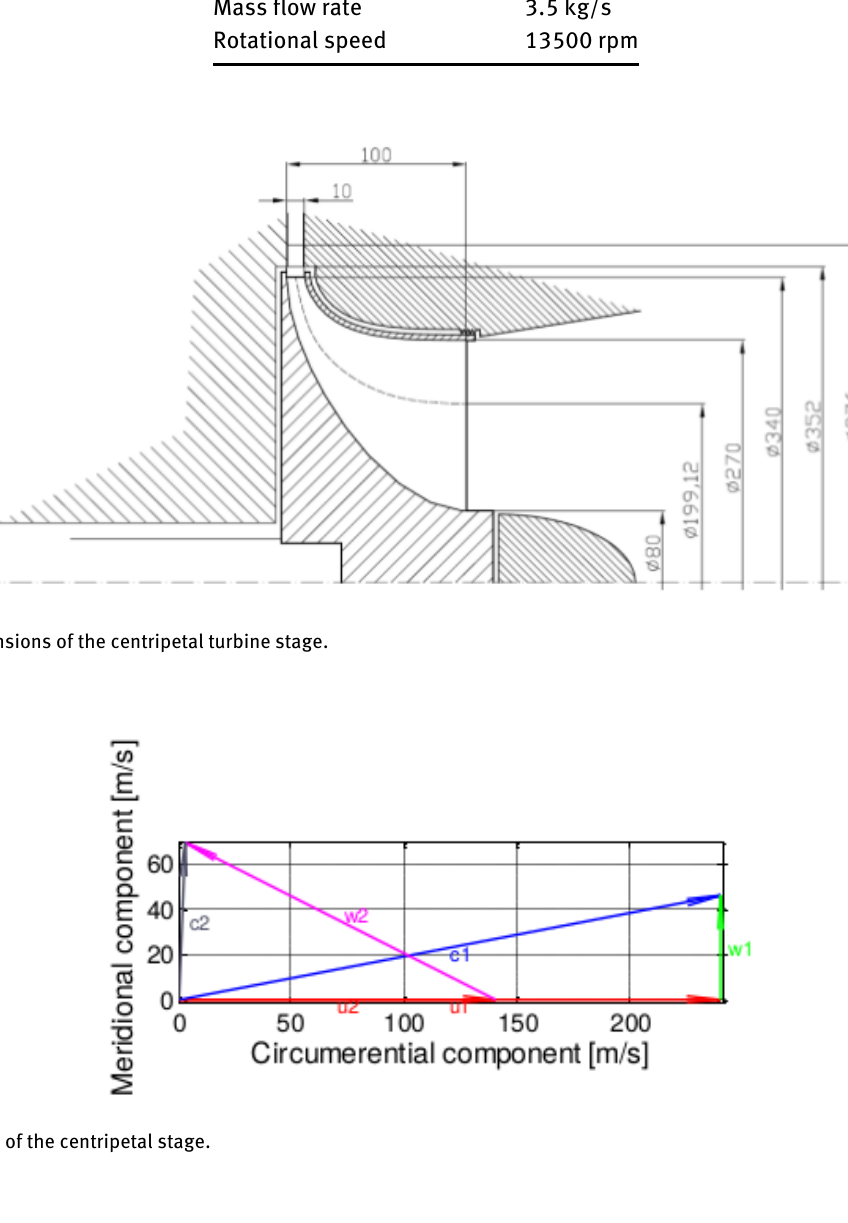
Table 7: Results of numerical simulations of the centripetal